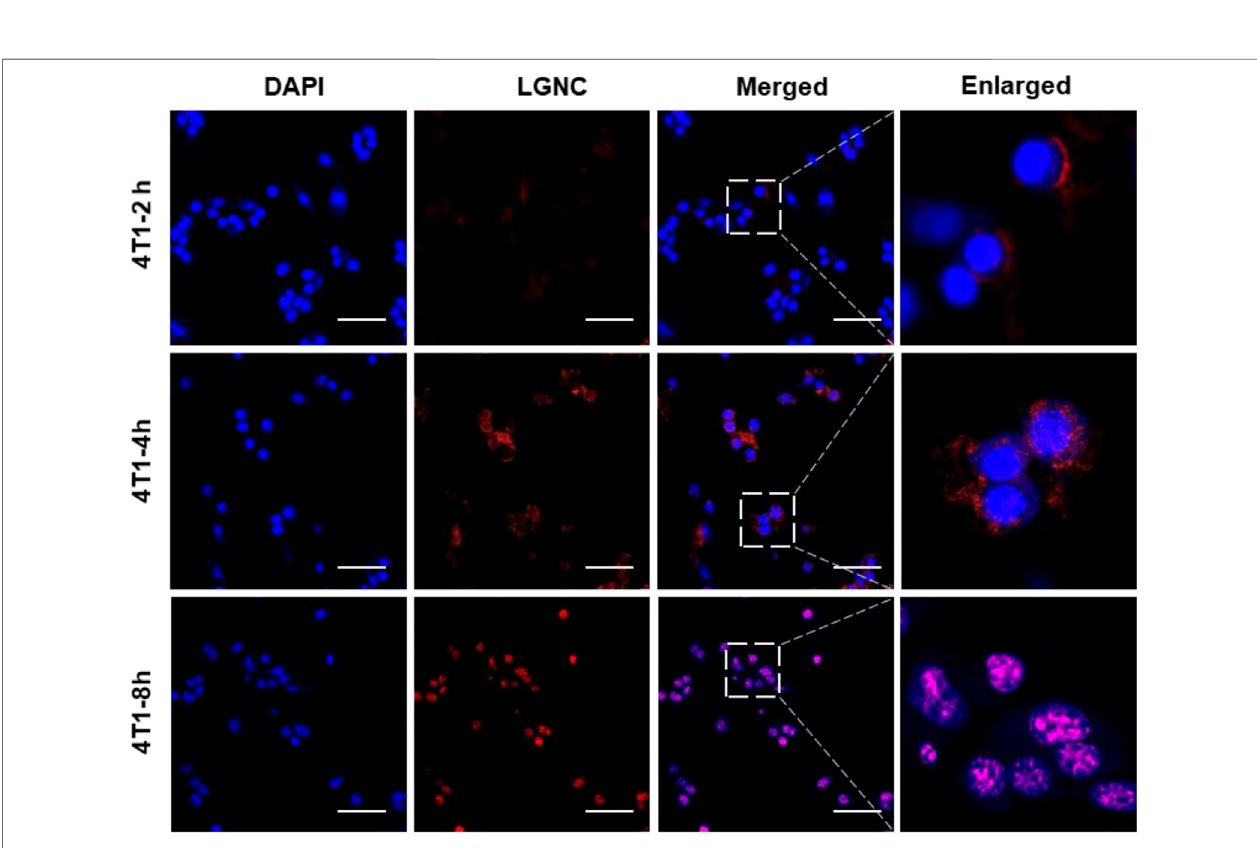
FIGURE 5 | CLSM images of subcellular distribution of LGNCs in 4T1 cells for various incubation times. The scale bar represents 50 μ m.